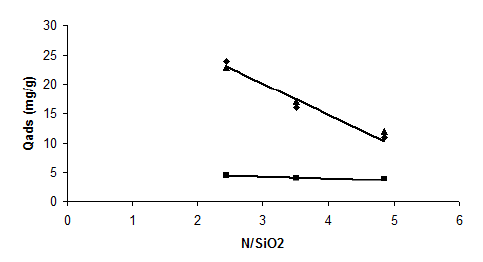
Figure 6. Adsorption capacity of para Chlorophenol [ ],